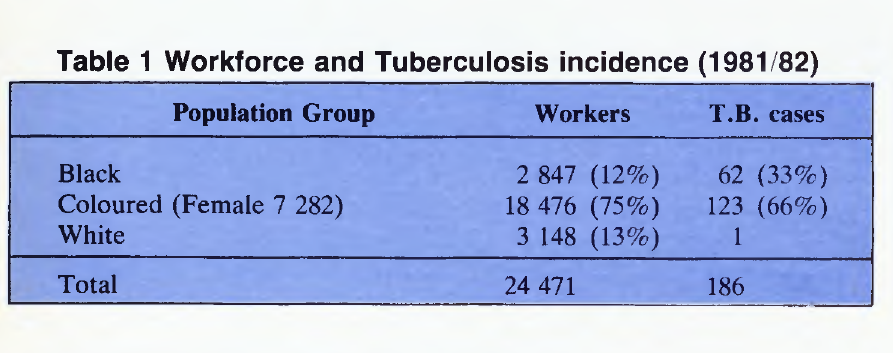
Table 2 Means of detection of Tuberculosis